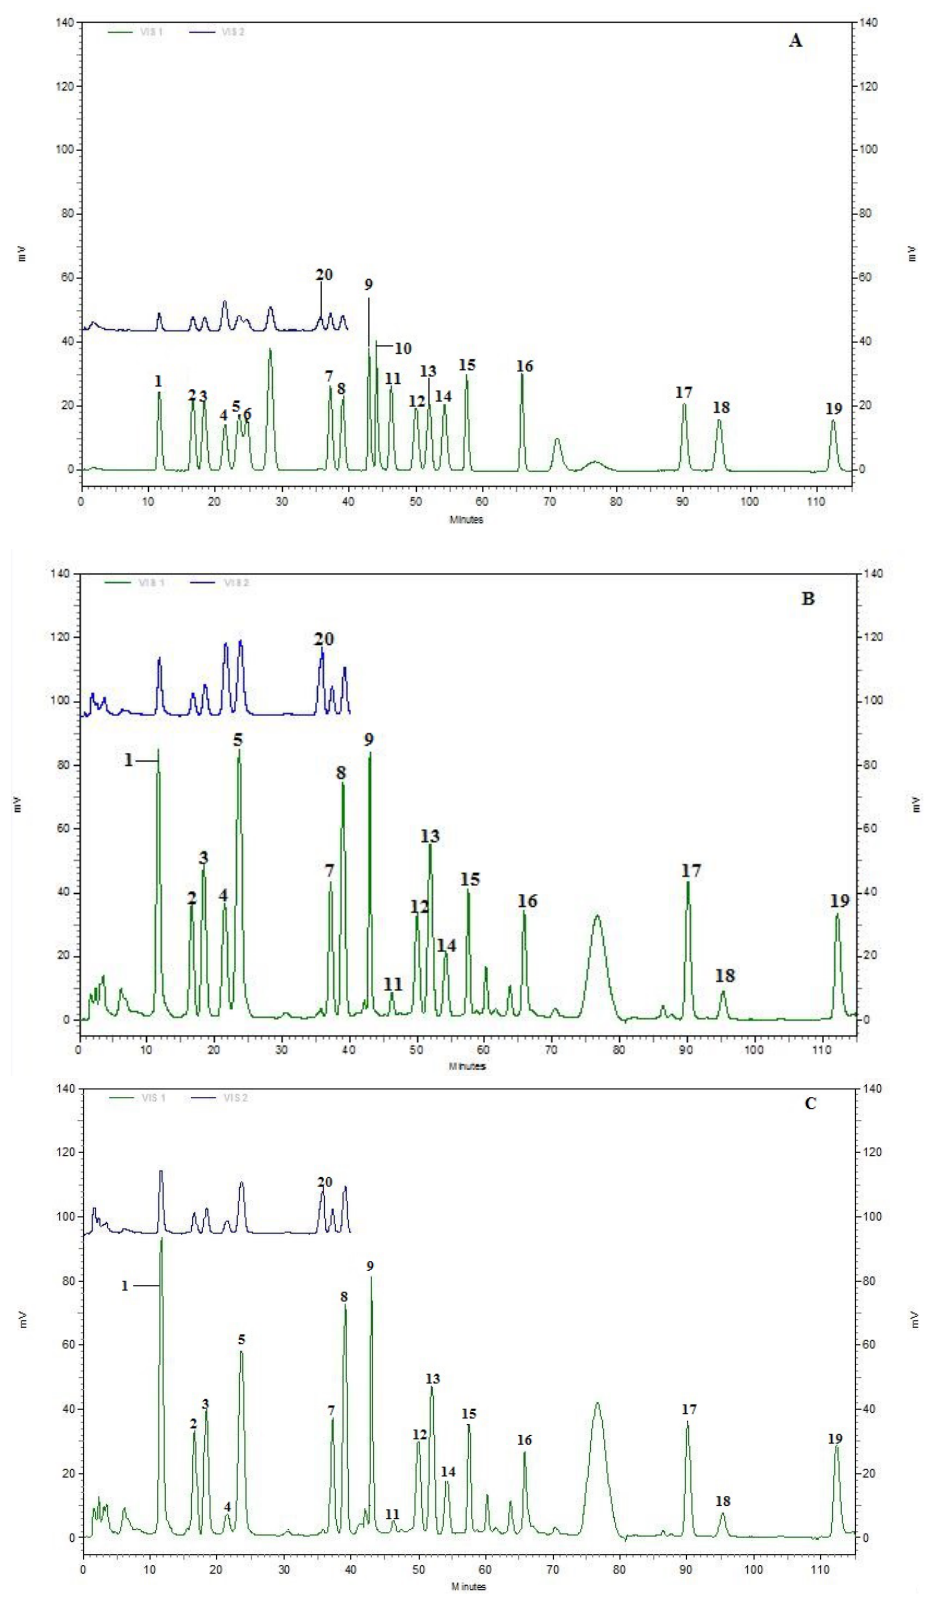
Figure 2. Results for amino acid analysis: ( A ) Standard solution of twenty amino acid (1: Asp; 2: Thr; 3: Ser; 4: Asn; 5: Glu; 6: Gln; 7: Gly; 8: Ala; 9: Val; 10: Cys; 11: Met; 12: Ile; 13: Leu; 14: Tyr; 15: Phe; 16: g-ABA; 17: Lys; 18: His; 19: Arg; 20: Pro); ( B ) Sample 1; ( C ) Sample 2. Table 3. The group of amino acids of different taste.